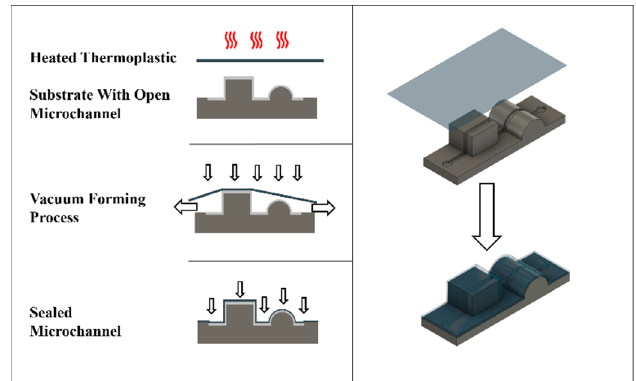
Figure 1. The fabrication process of topographical vacuum sealing. A thermoplastic is heated above its glass transition temperature and stretched over the topographic substrate. The vacum alignes the thermoplastic to the surface of the substrate, while the microchannels remain free due to their small size.